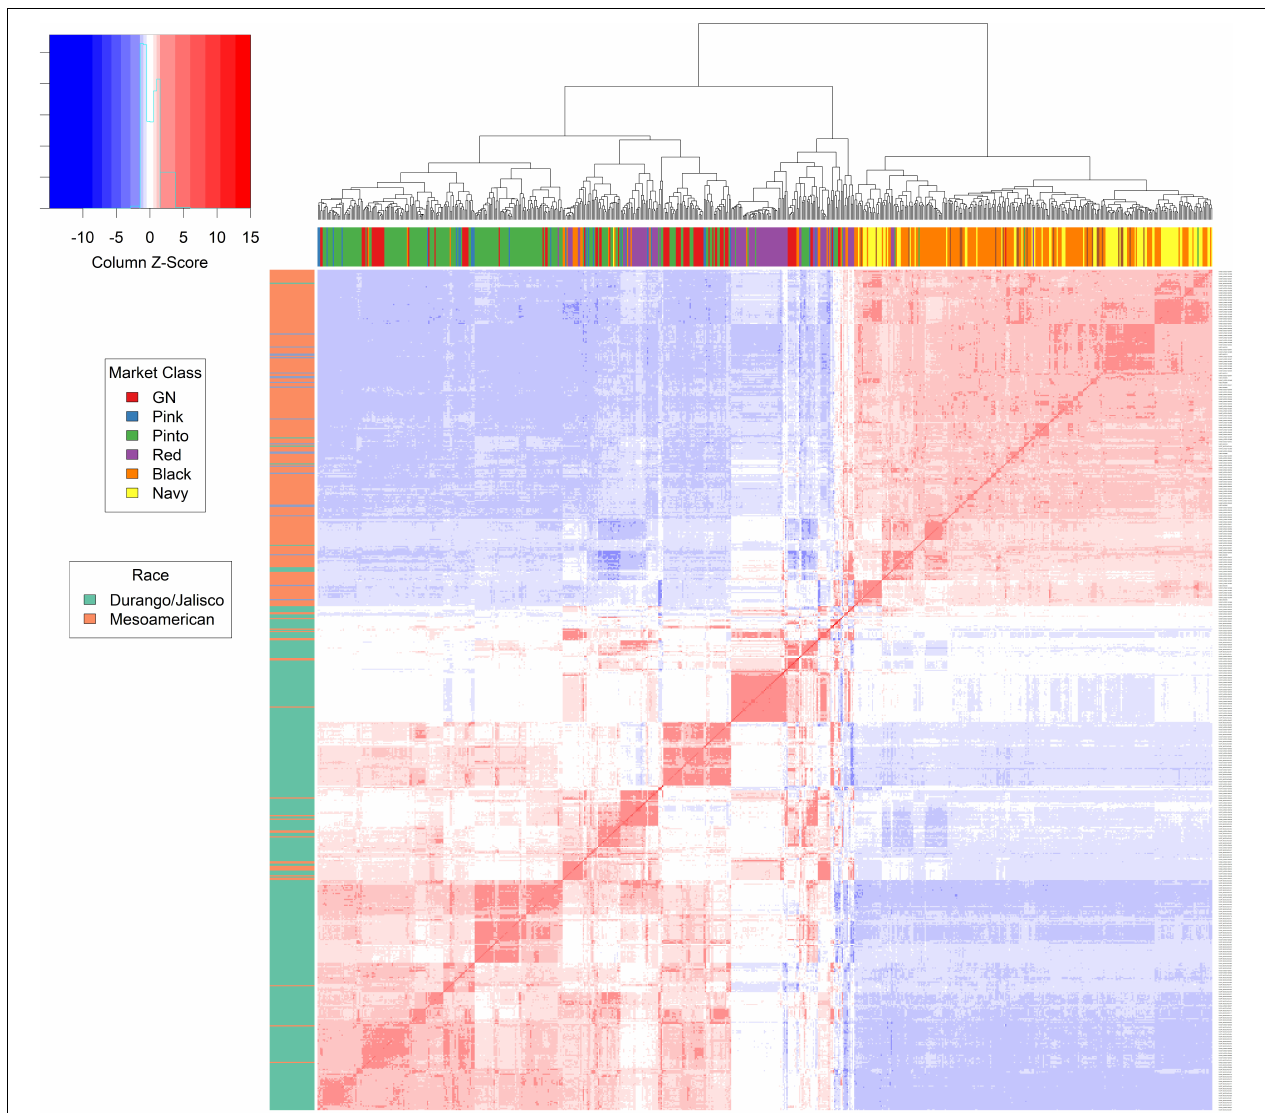
FIGURE 1 | The kinship matrix from GEMMA provides an in-depth view of the relation between each genotype within the Middle American population. The matrix is represented by a heat map. The box plot to left of the heat map represents the race of the genotype based on breeding characteristics. The box plot directly above the heat map displays the market class of each genotype. Hierarchical clustering of the genotypes is depicted above the market class box plot.